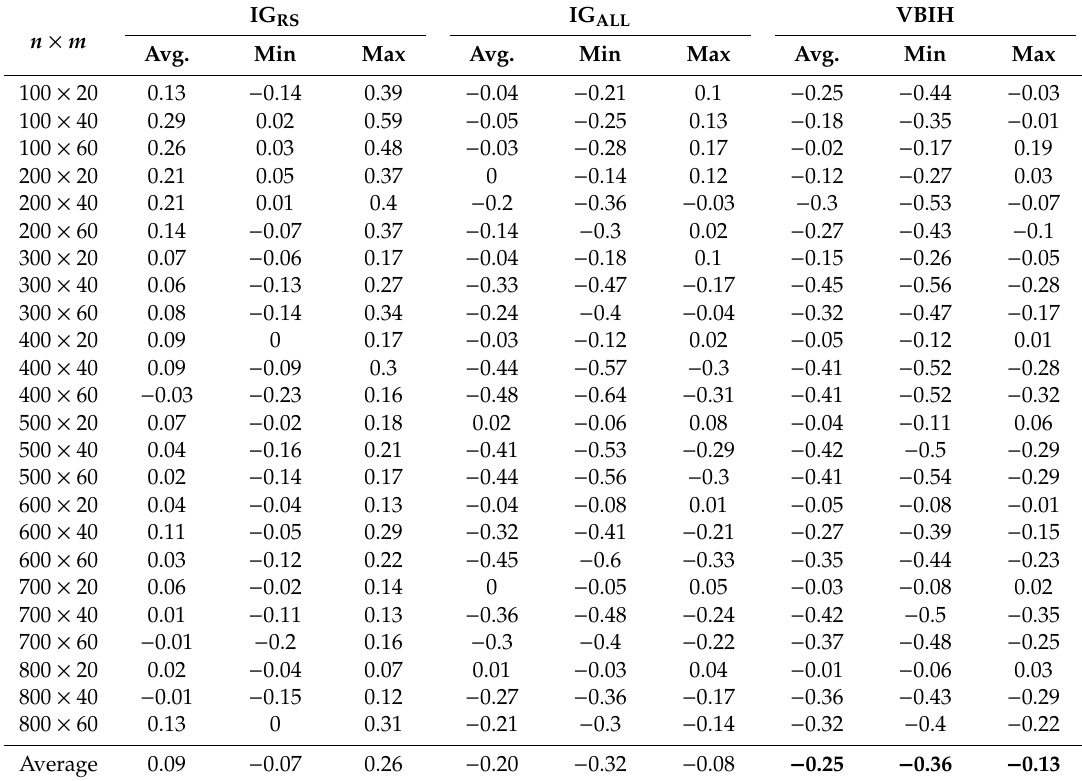
Table 8. Computational results of algorithms with T max = 45 × n × m milliseconds (The bolds show better